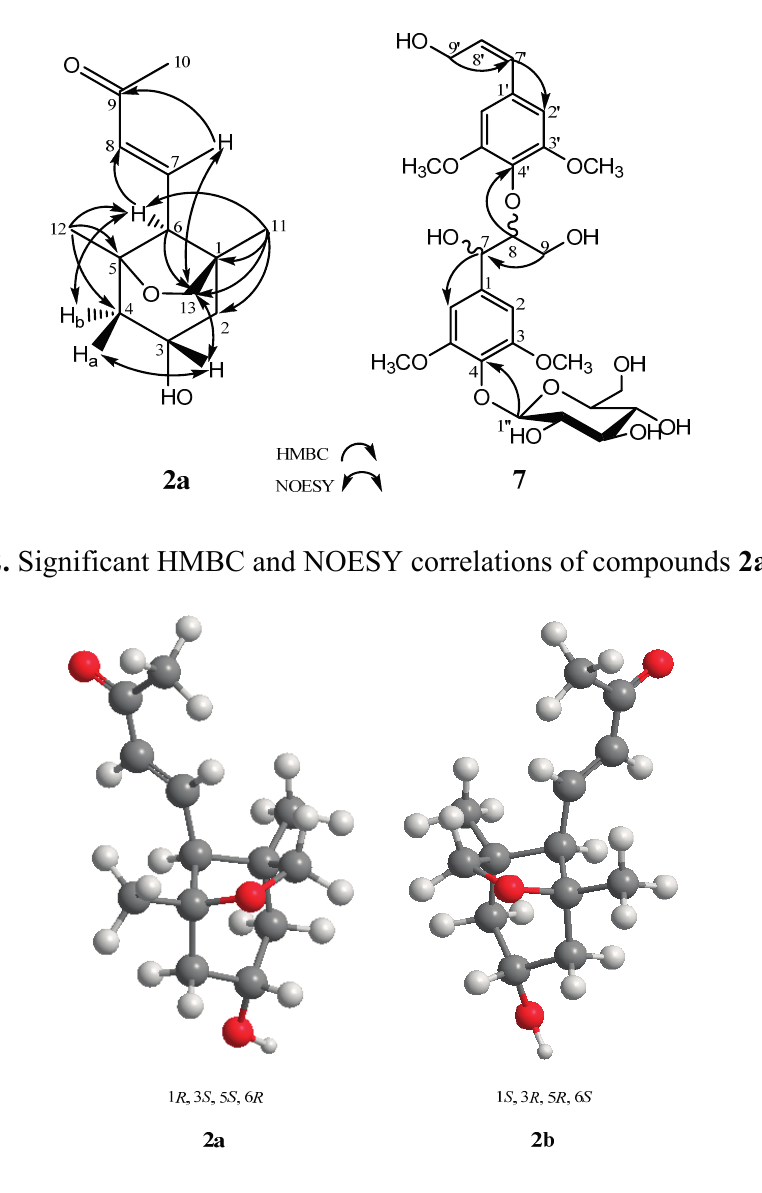
Figure 3. The relative configuration of compound 2